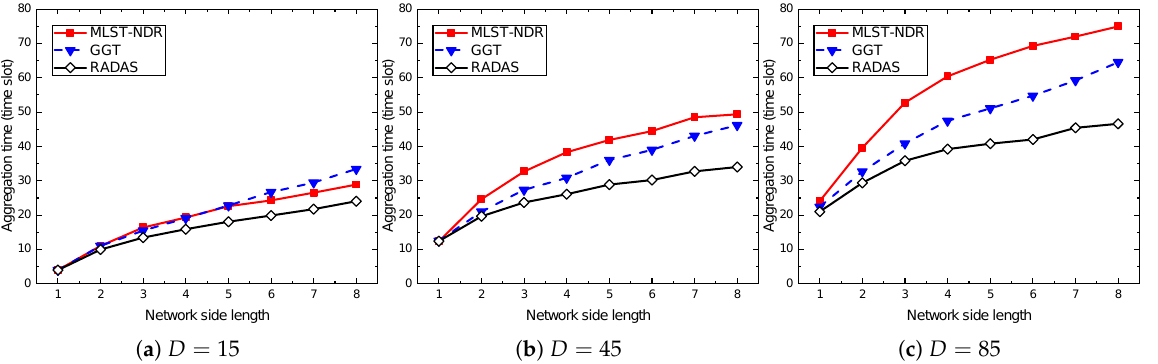
Figure 9. Aggregation time comparison when network side length varies.